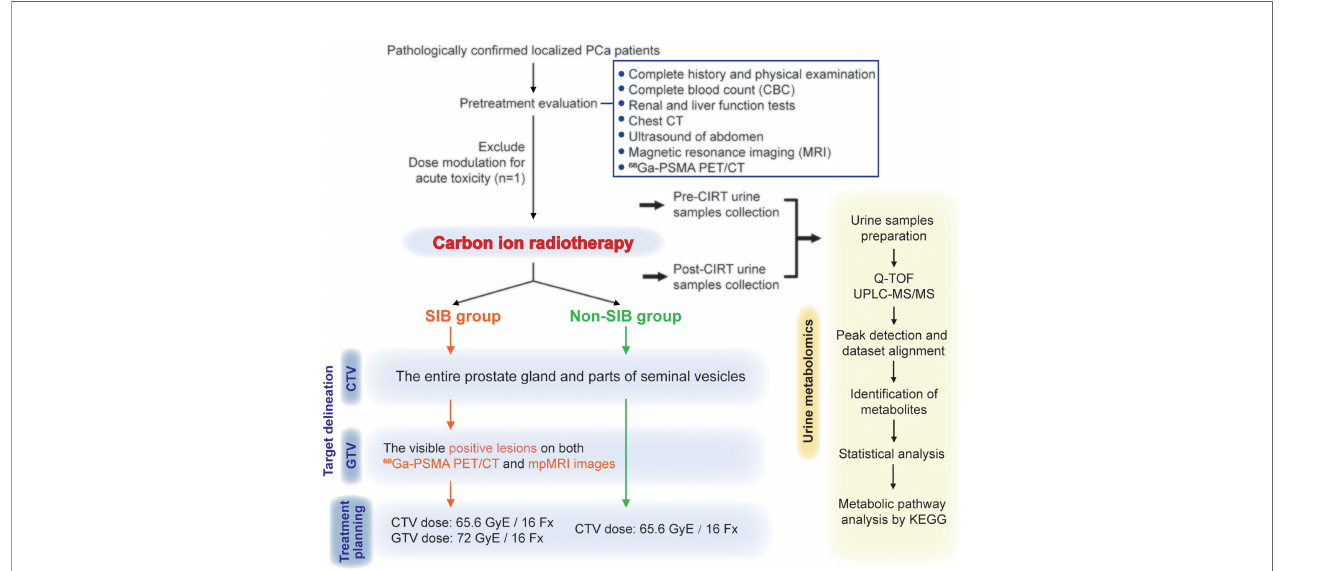
FIGURE 1 | Flowchart of patients. This study enrolled 24 pathologically con fi rmed localized PCa patients. The delineation of CTVs were consistent in the two groups. Patients in the SIB group received the SIB on positive lesions that were visible on both 68 Ga-PSMA PET/CT and mpMRI images. Urine samples were collected at the start and the end of CIRT, and then went through the metabolomic analysis process.